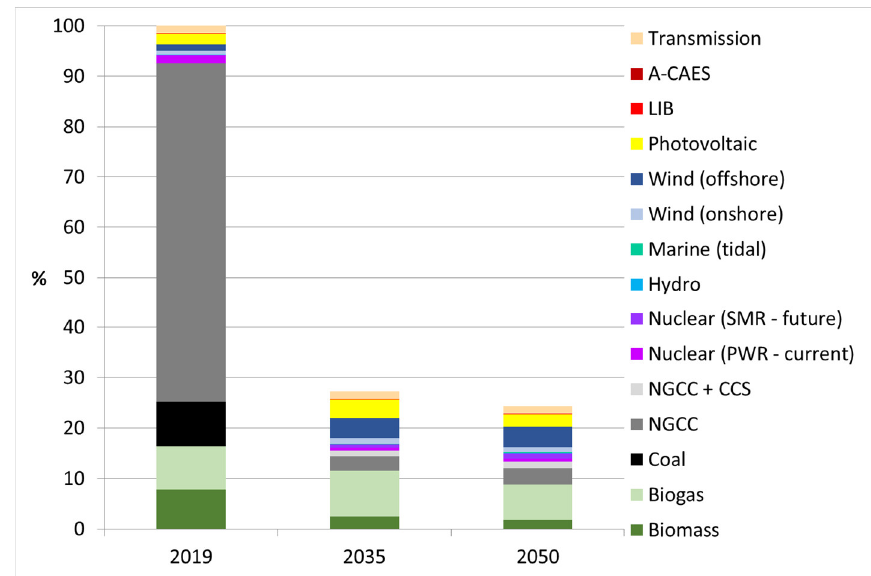
Figure 8. Global warming potential (excluding biogenic carbon) per unit of electricity delivered by the UK grid mix (including energy storage and transmission), expressed as relative to the 2019 value (100% = 170 g CO 2 -eq/kWh).